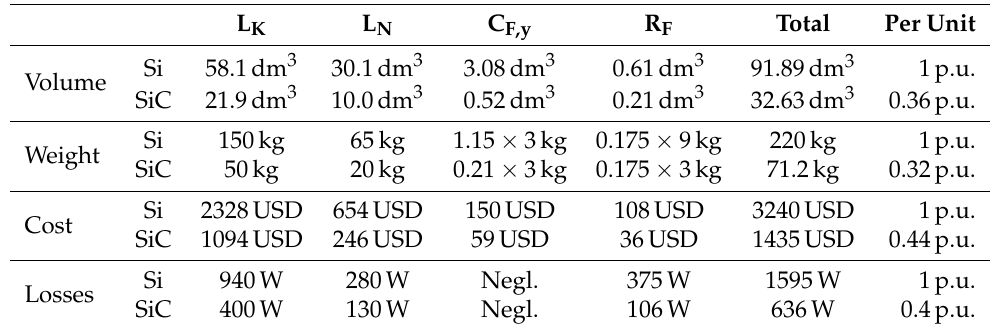
Table 7. Components and characteristics of LCL-Filter physical implementation.